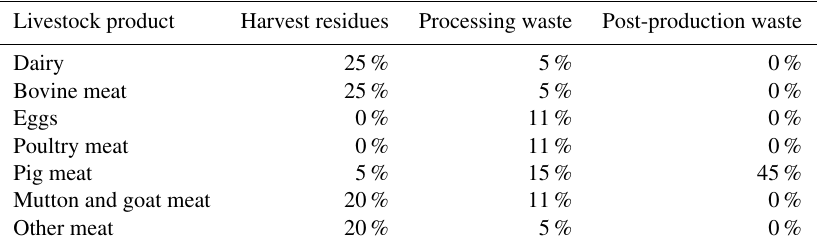
Table C1. Maximum portion ( z ) of livestock feed that can be derived from each residue source. These values are taken from FALAFEL (Powell, 2015).